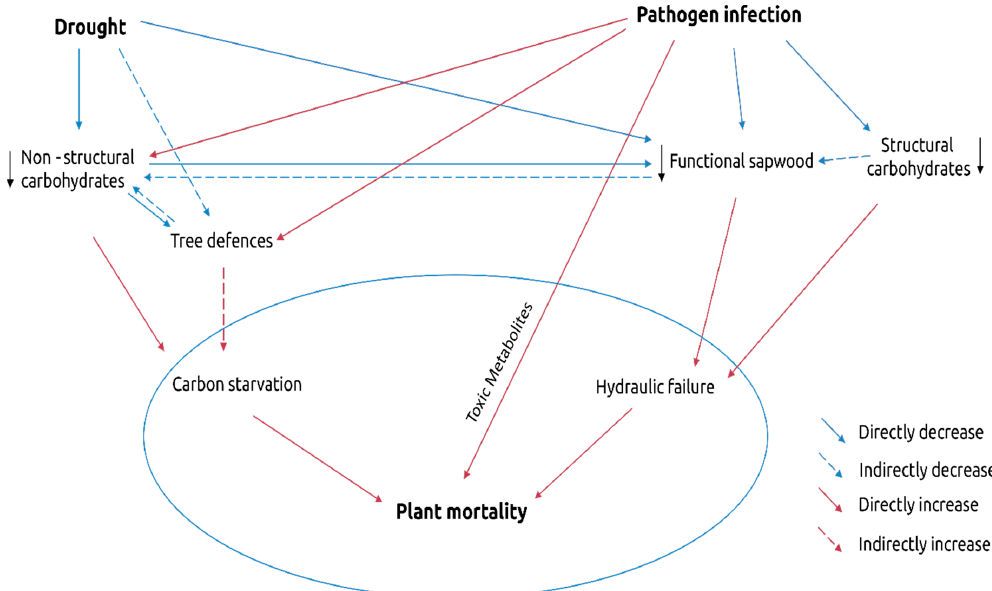
Figure 6. Combined effects of drought and pathogen infection on plant functioning, growth, and mortality. Adapted from [72,74].